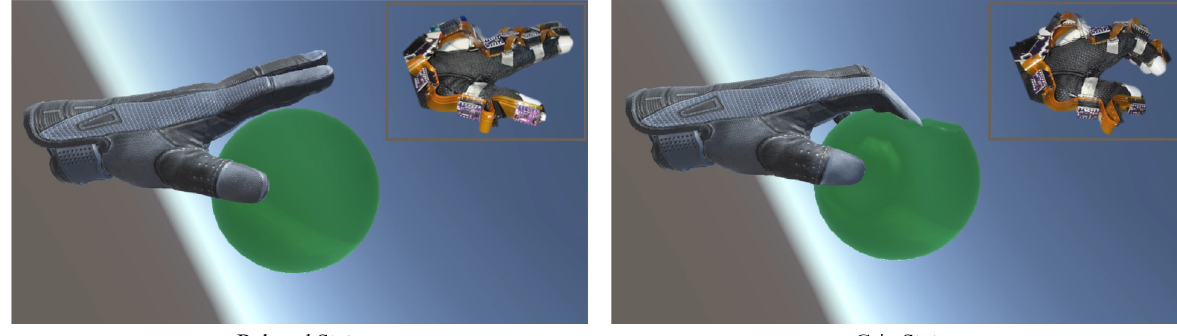
Figure 13. Real-time VR scene